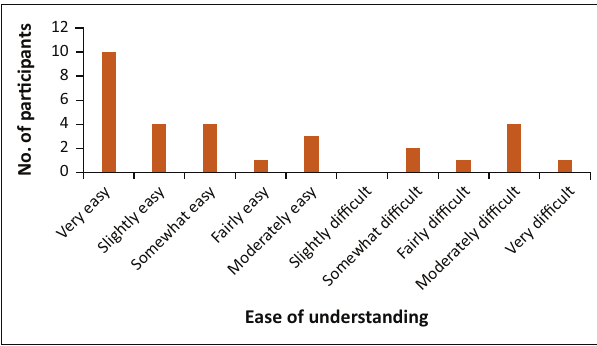
FIGURE 1: Ease of understanding the translated tool ( n =